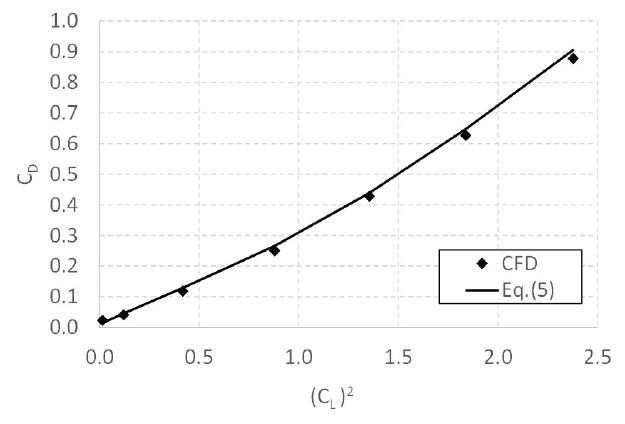
Figure 13. Aircraft’s drag polar up to α = 30 ◦ .